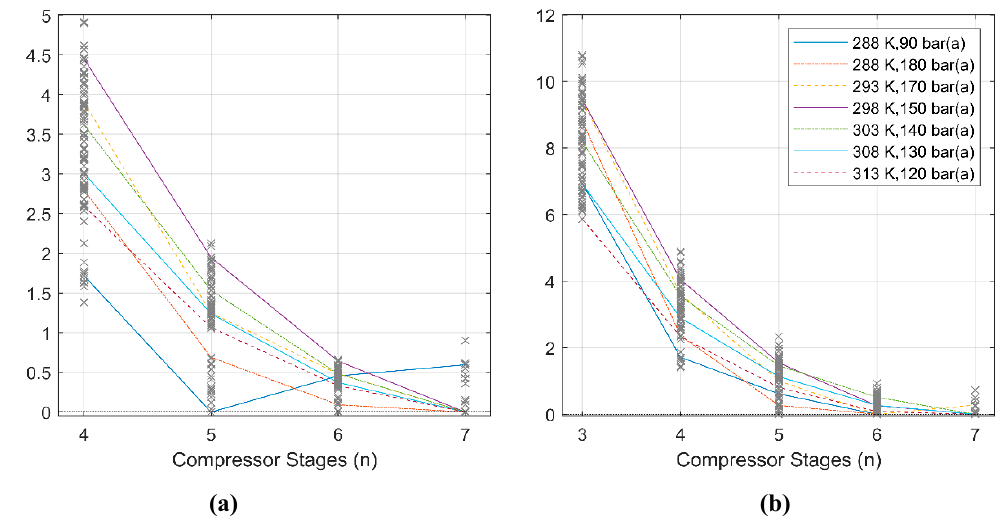
Figure 6. Relative energy consumption vs. compressor stage, oxyfuel cases, ( a ) constrained cases and ( b ) unconstrained cases.